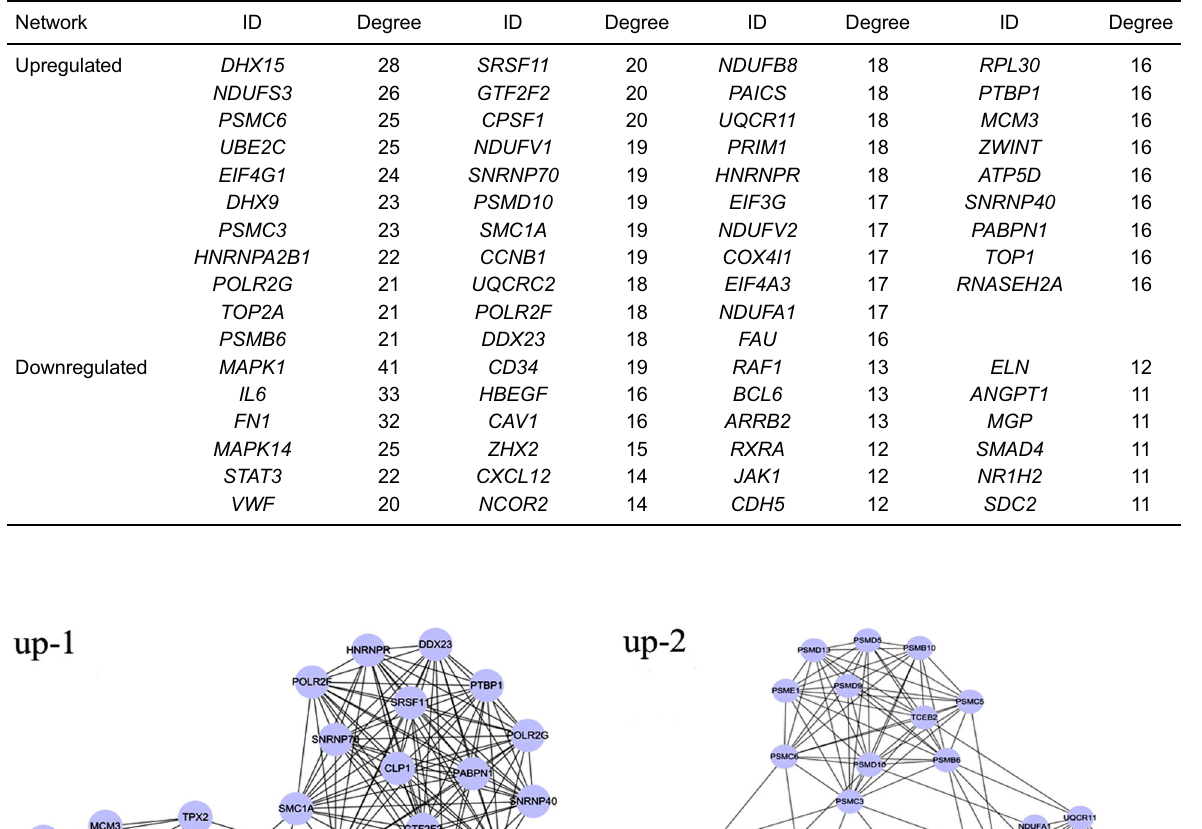
Table 1. Differentially expressed genes with the top 10% connectivity degree in upregulated and downregulated protein-protein interaction networks.